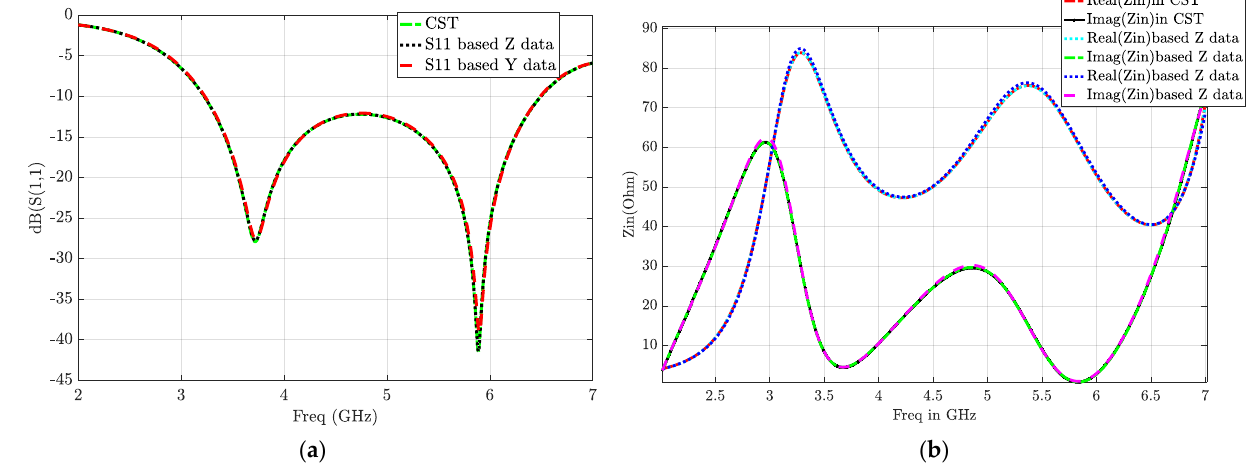
Figure 6. ADS model of the lumped equivalent circuit based on Y data.